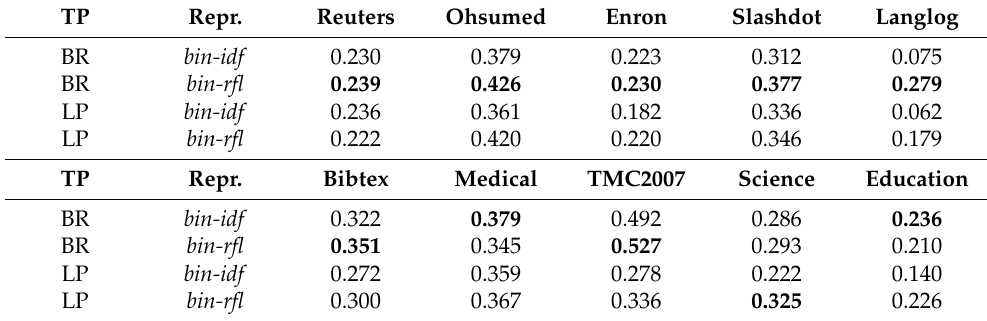
Table 10. Experimental results of different transformations of the problem (PT: BR and LP), and Representations with SVM in terms of macro- F 1